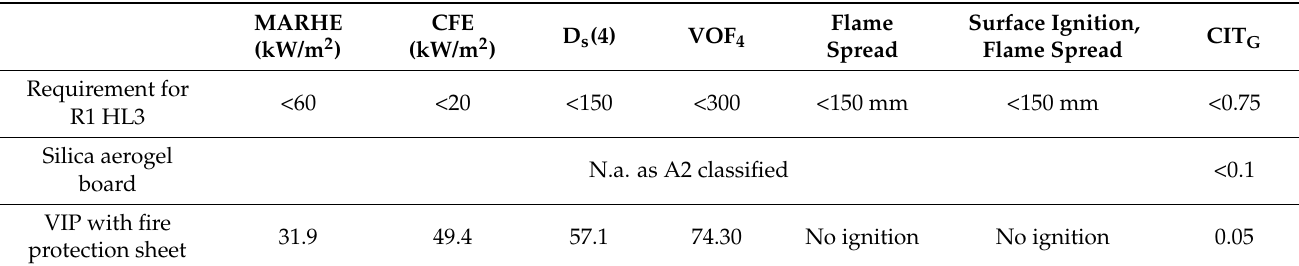
Table 3. Results of the fire tests for the silica aerogel board and the VIP with a fire protection layer. Each measurement is determined with three samples. Values given represent mean